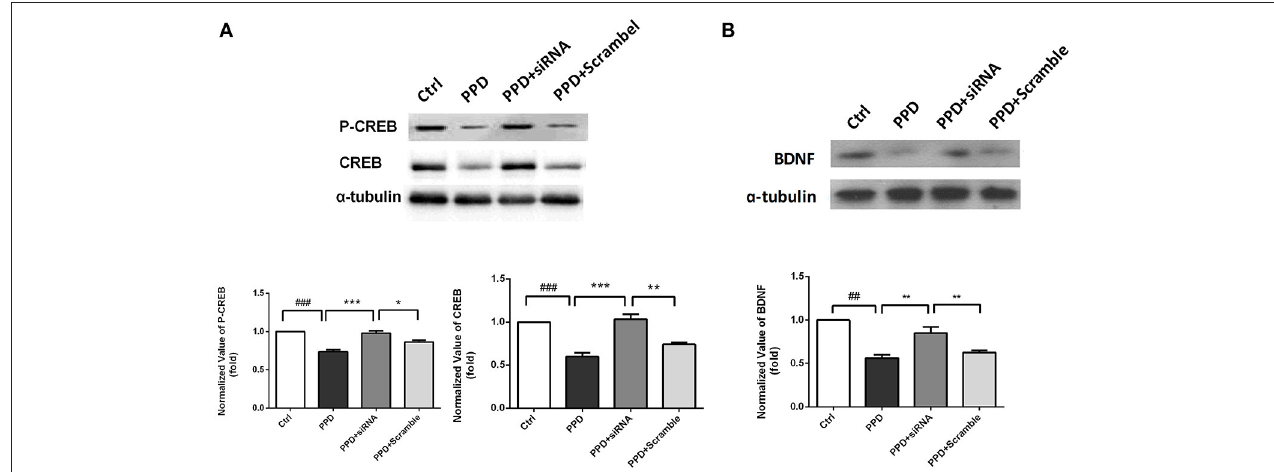
FIGURE 5 | siRNA-GALR1 interference reversed the decreased protein levels of CREB, P-CREB and BDNF in the PFC. All data are expressed relative to Ctrl group. (A) CREB and P-CREB protein levels were significantly decreased in PPD groups, while GALR1-siRNA treatment up-regulated CREB and P-CREB levels to